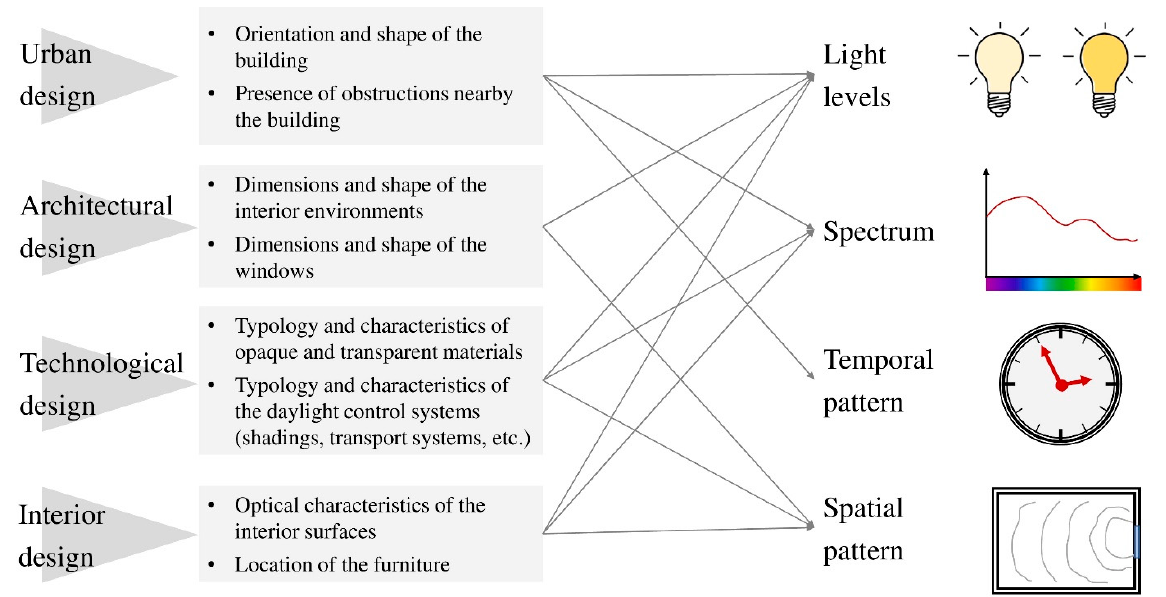
Figure 1. Design factors modifying light characteristics, in turn affecting circadian systems.